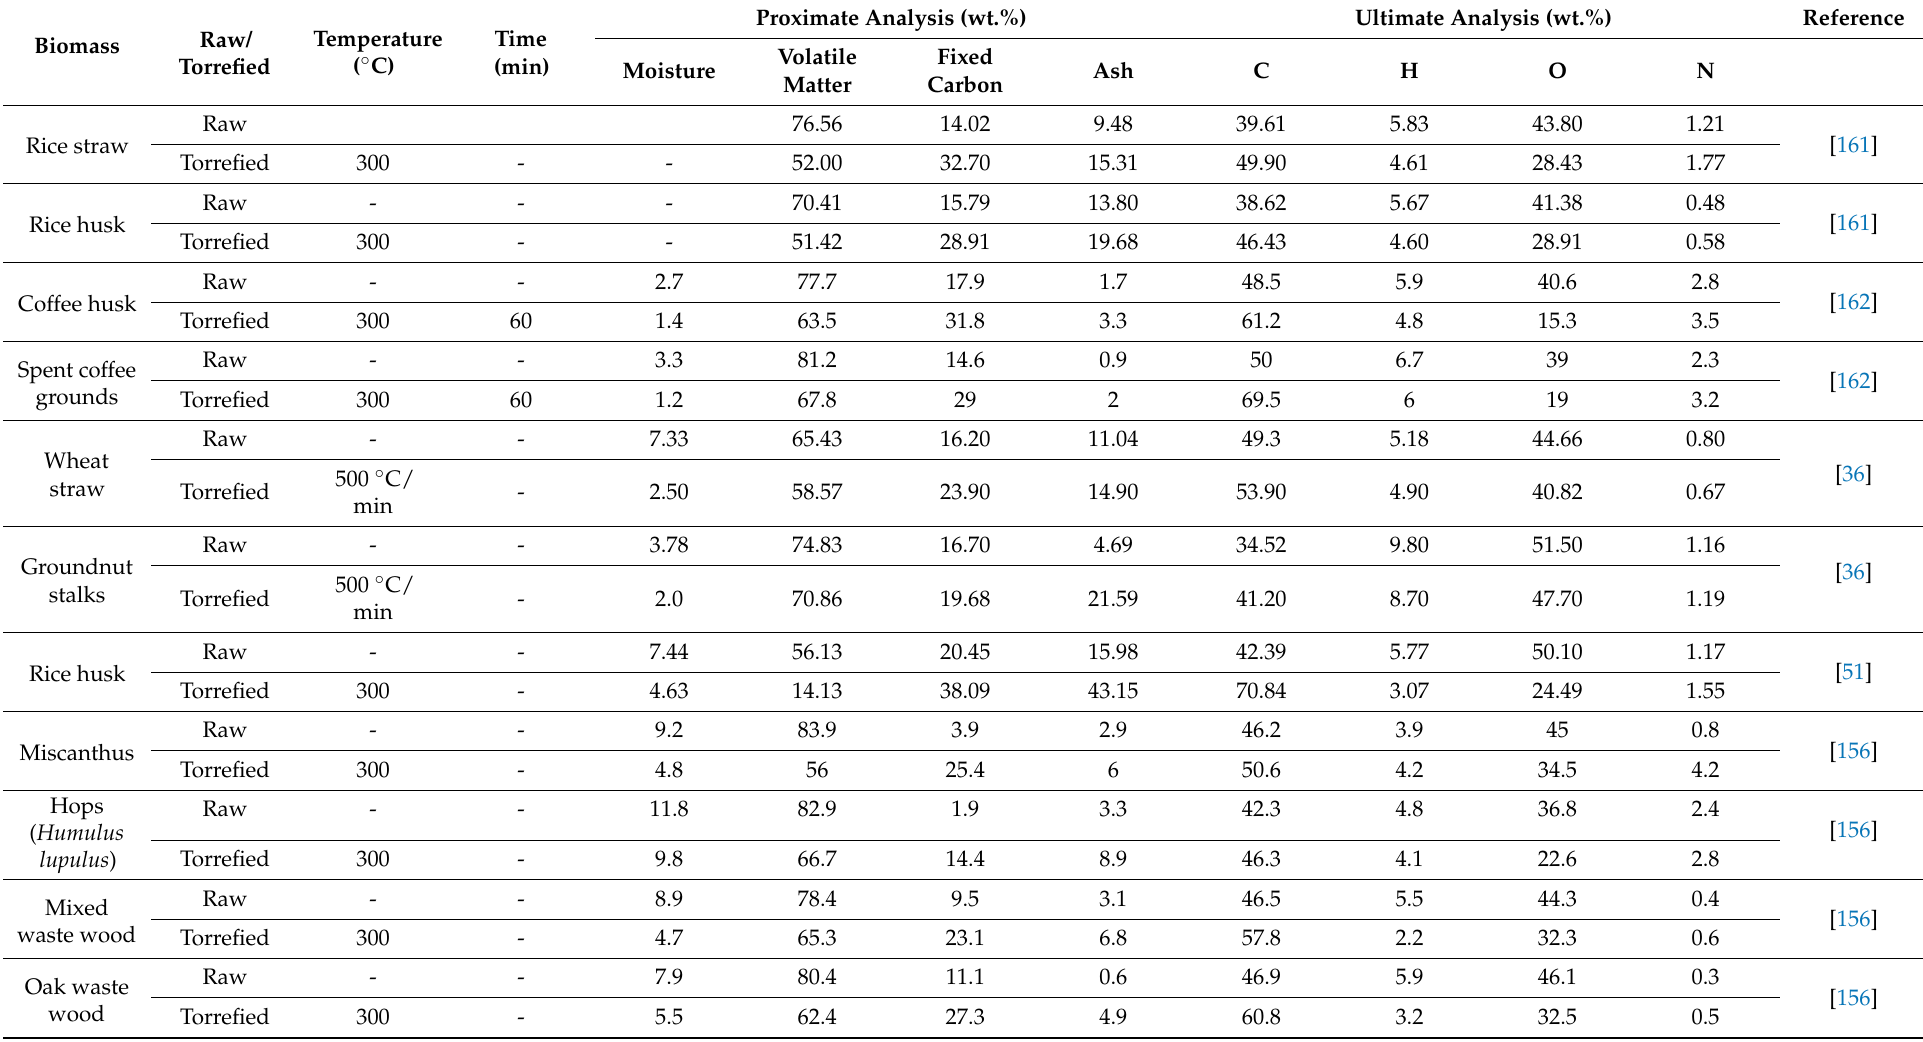
Table 3. Lignocellulosic biomass proximate and ultimate analysis results before and after dry